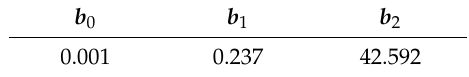
Table 10. Identification results of parameters of STD. of the stress–strain curve STD σ ( ε )